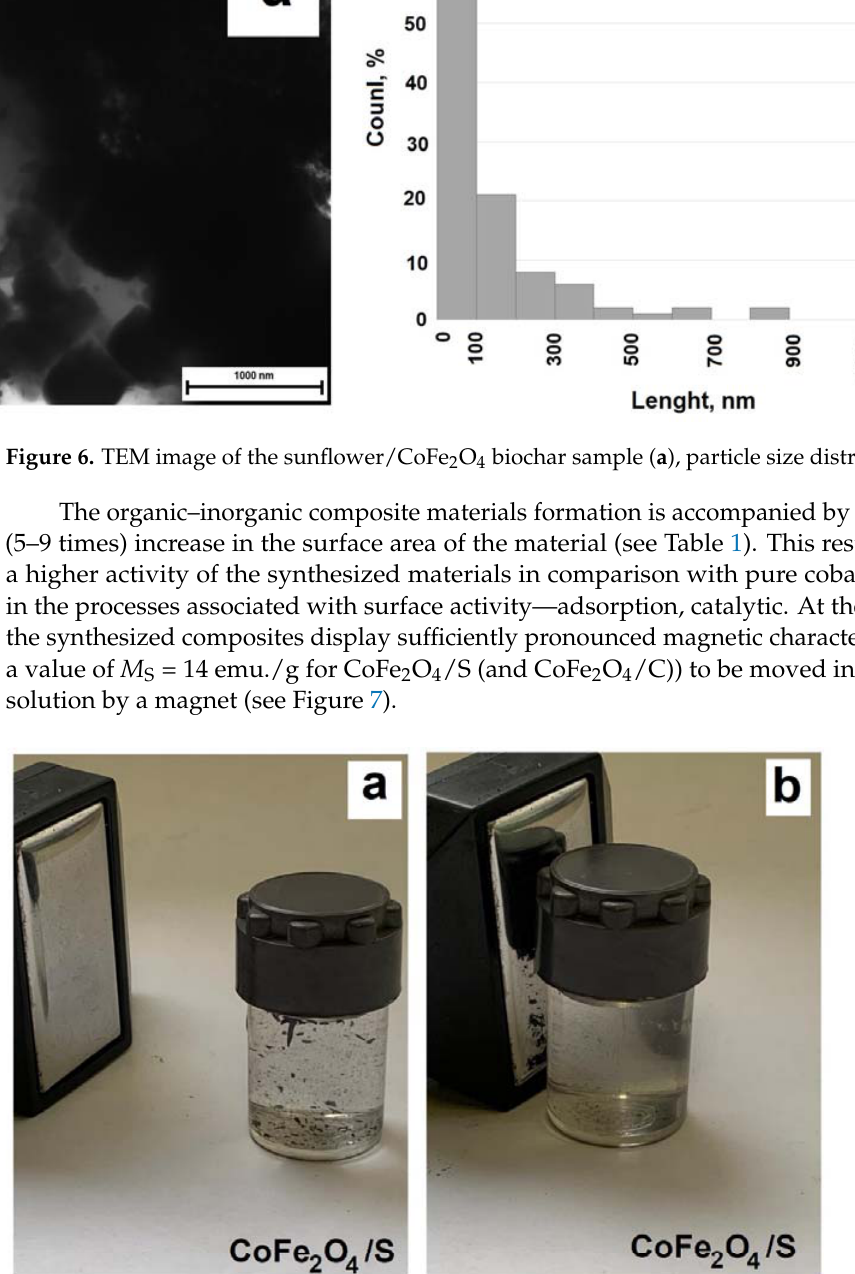
Figure 7. Magnetic separation of synthesized material: composites ( a – d ), schematic representation ( e , f ). The synthesized materials were tested in the process of adsorption of chromium (VI) compounds from an aqueous solution. The results are shown in Table 2.